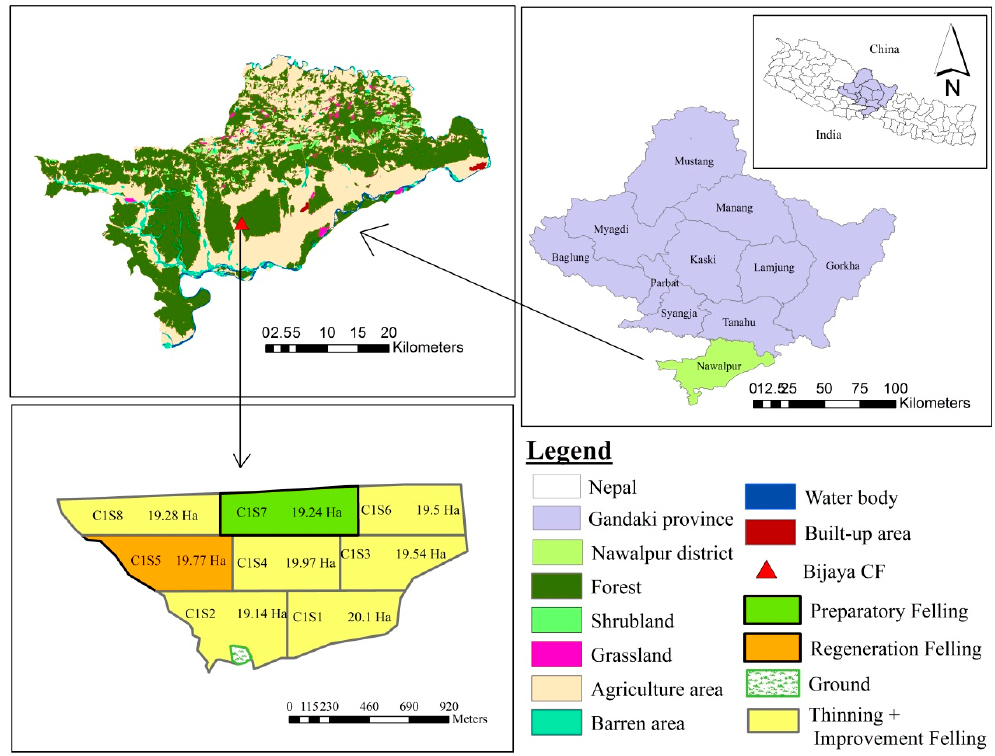
Figure 1. Location map of the study area (Source: Operational plan of the community forest user group (CFUG), 2016).